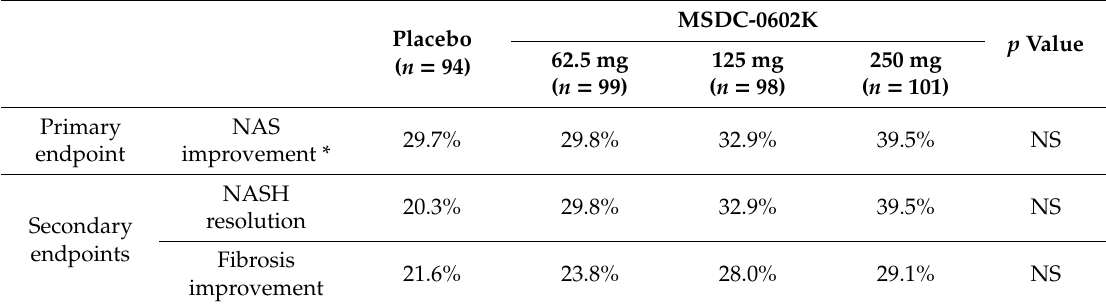
Table 2. MSDC-0602K e ff ects in NASH liver histology (EMMINENCE trial, Phase 2a).